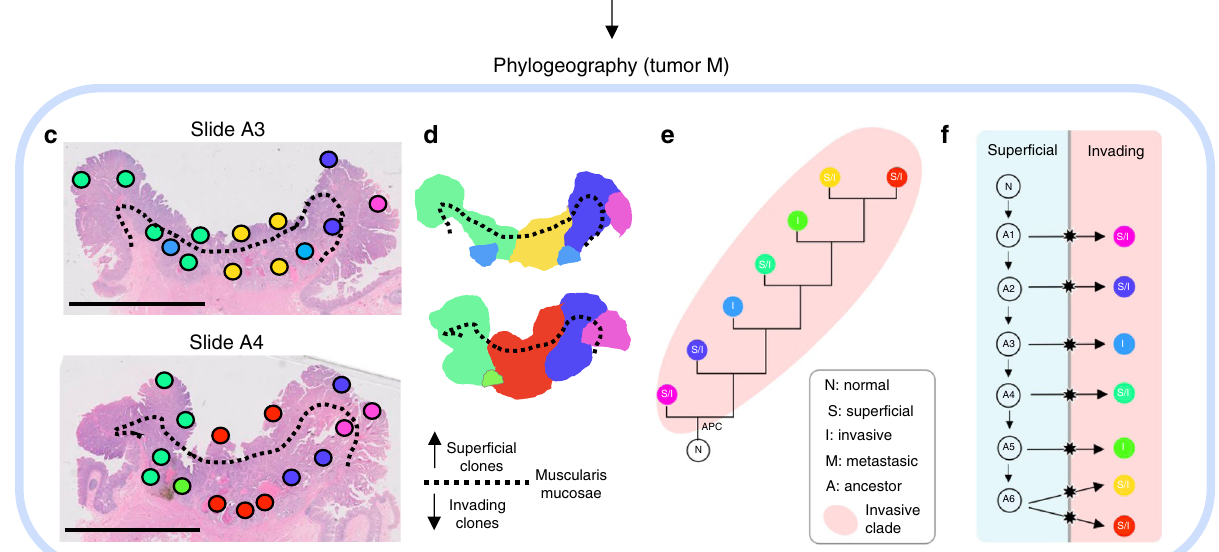
47, range: 13 – 110) was derived from a previous whole-exome sequencing study 9 (Fig. 2b). Deep (mean depth ~9000x; mini- mum depth: 20x) targeted re-sequencing of the tumor-speci fi c mutation panels was performed. Variant allele frequencies (VAF) of private mutations were comparable to those of public muta- tions (Supplementary Fig. 1, Supplementary Data 1), consistent with the presence of a single subclone in each spot. Indeed, of 325 analyzed spots, only four harbored multiple subclones as indi- cated by low private mutation VAFs and homoplasy